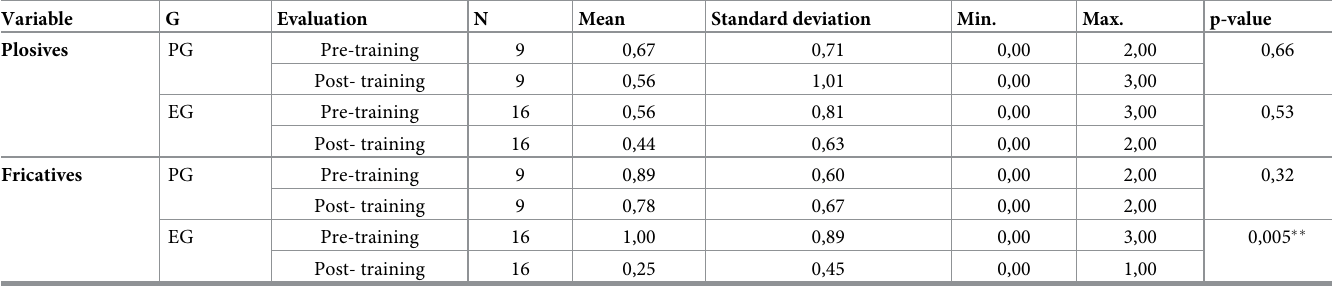
Table 3. Amount of errors related to plosive and fricative graphemes in the two groups, considering the two evaluations. Variable